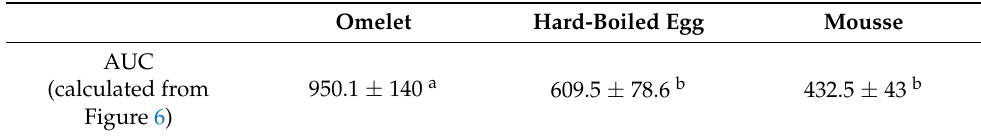
Table 3. Bioavailability of DHA included in DHA-enriched omelet, hard-boiled egg, and mousse, evaluated by measuring the area under the curve (AUC) of base-line adjusted DHA concentration in plasma throughout 48 h postprandial after the ingestion of each egg